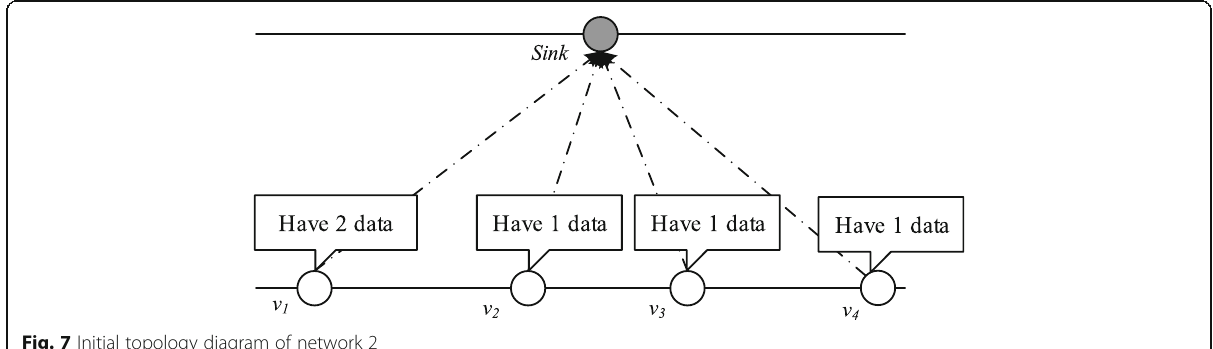
Fig. 7 Initial topology diagram of network 2